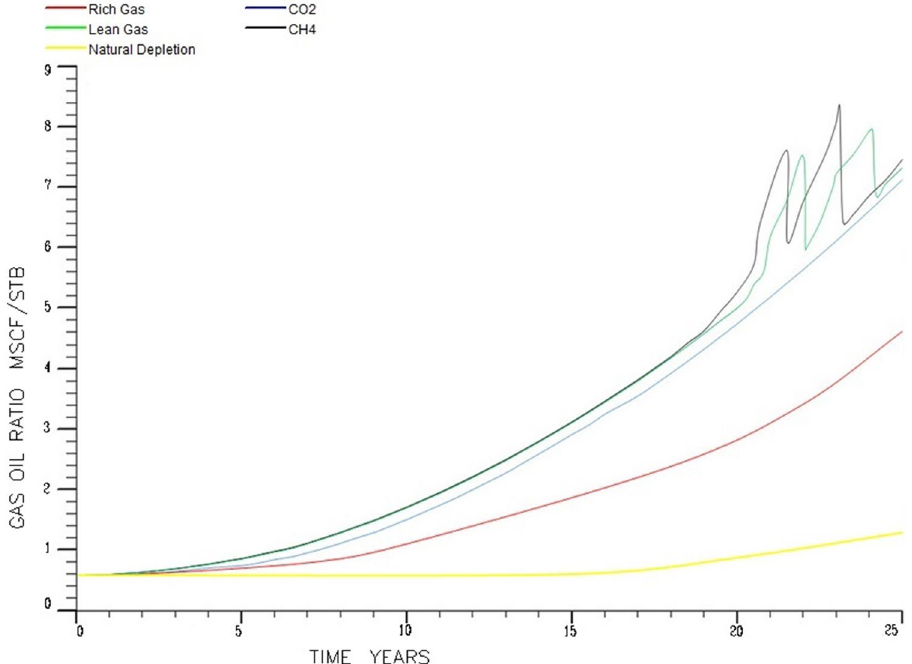
Fig. 5 Producing gas–oil ratio in different gas injection cases